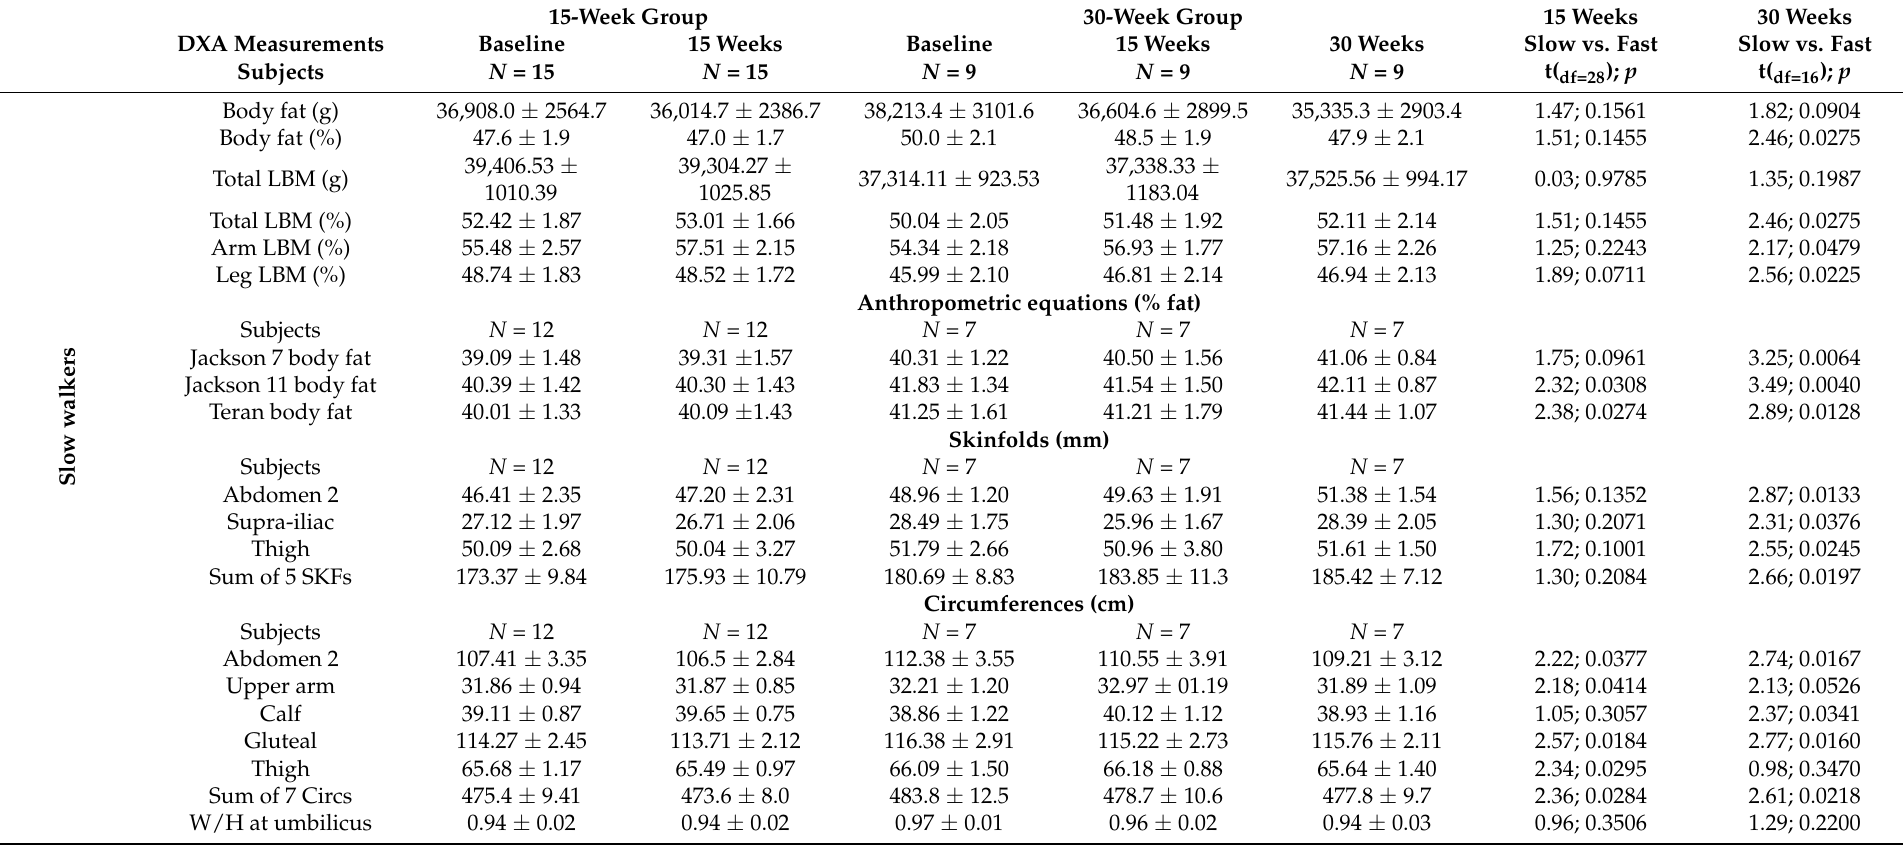
Table 6. Effects of walking speed on total and regional fat distribution after 15 and 30 weeks of walking measured by DXA and anthropometric